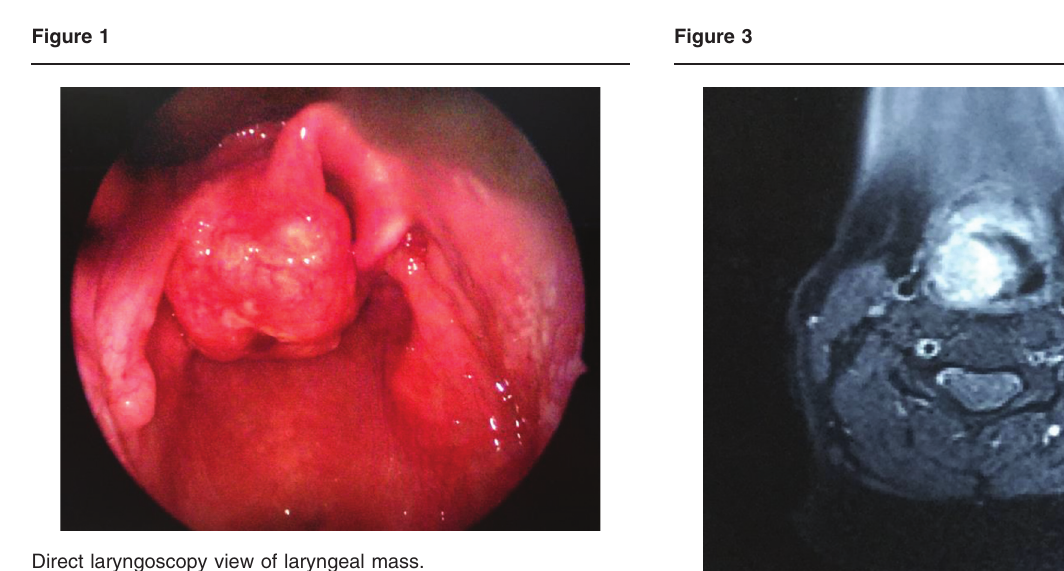
Axial view of MRI of